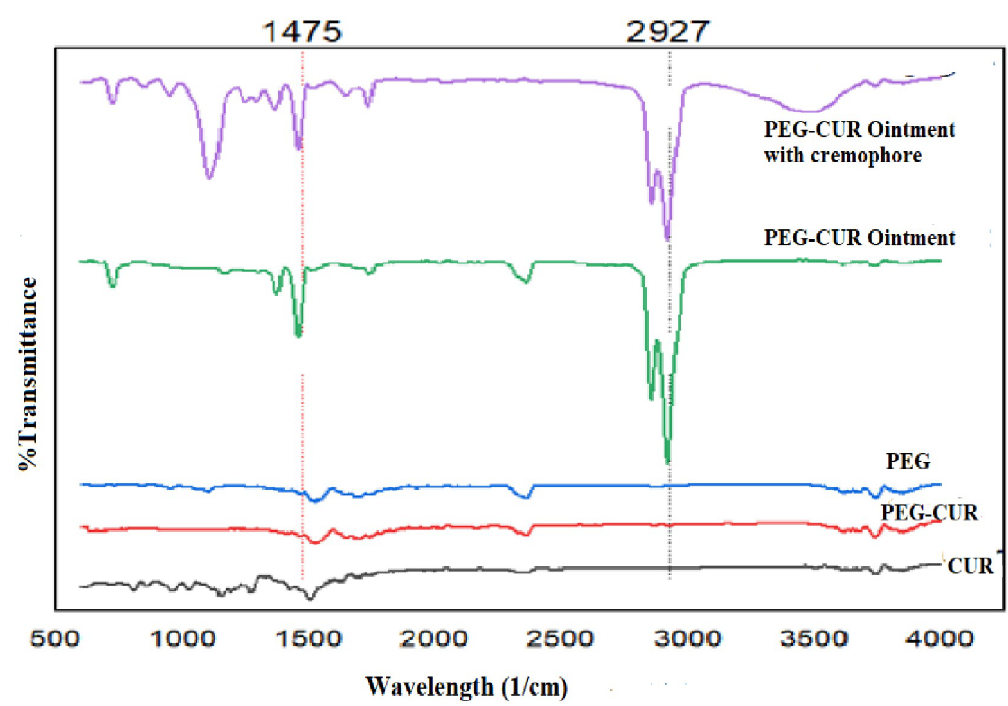
Fig 4. FTIR-spectra of pure curcumin, PEG-Curcumin, PEG, PEG-CUR Ointment and PEG-CUR Ointment with cremophore.